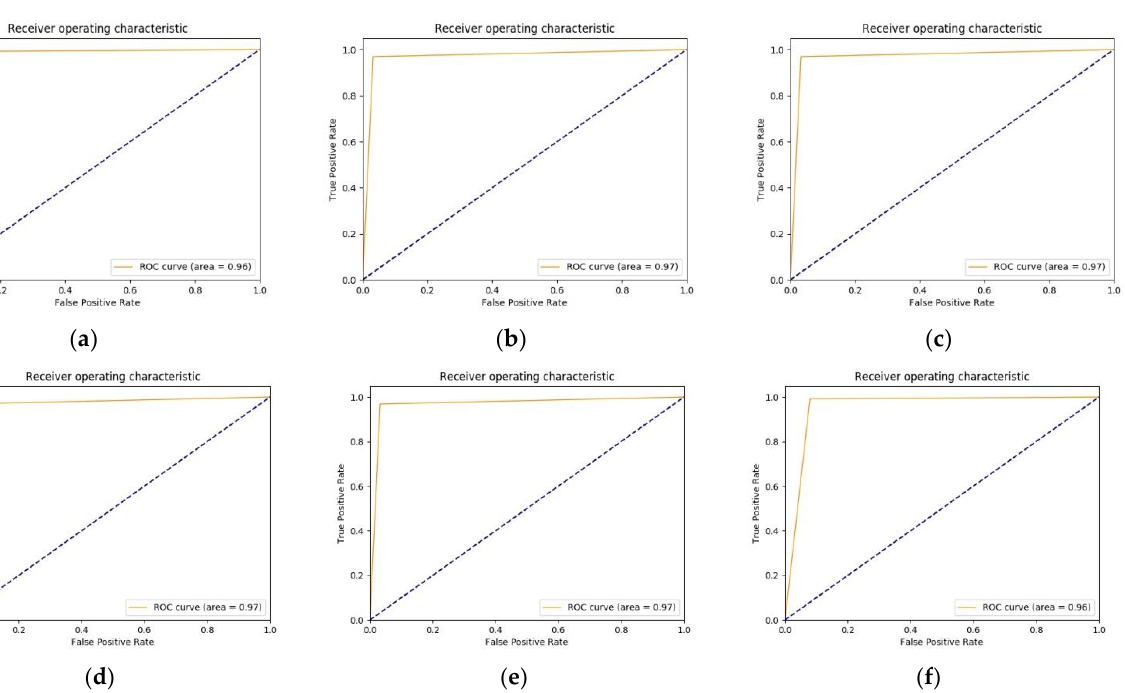
Table 1. Pretrained models with performance metrics along with SD.